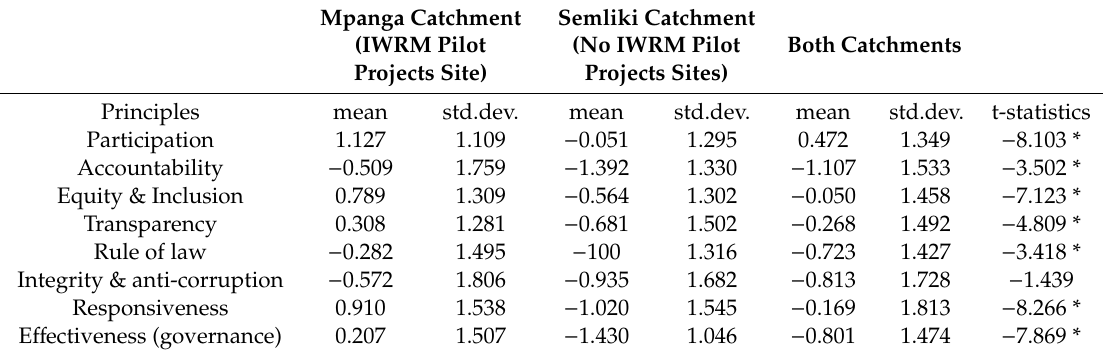
Table 4. Water governance principles significance tests in Mpanga and Semliki river